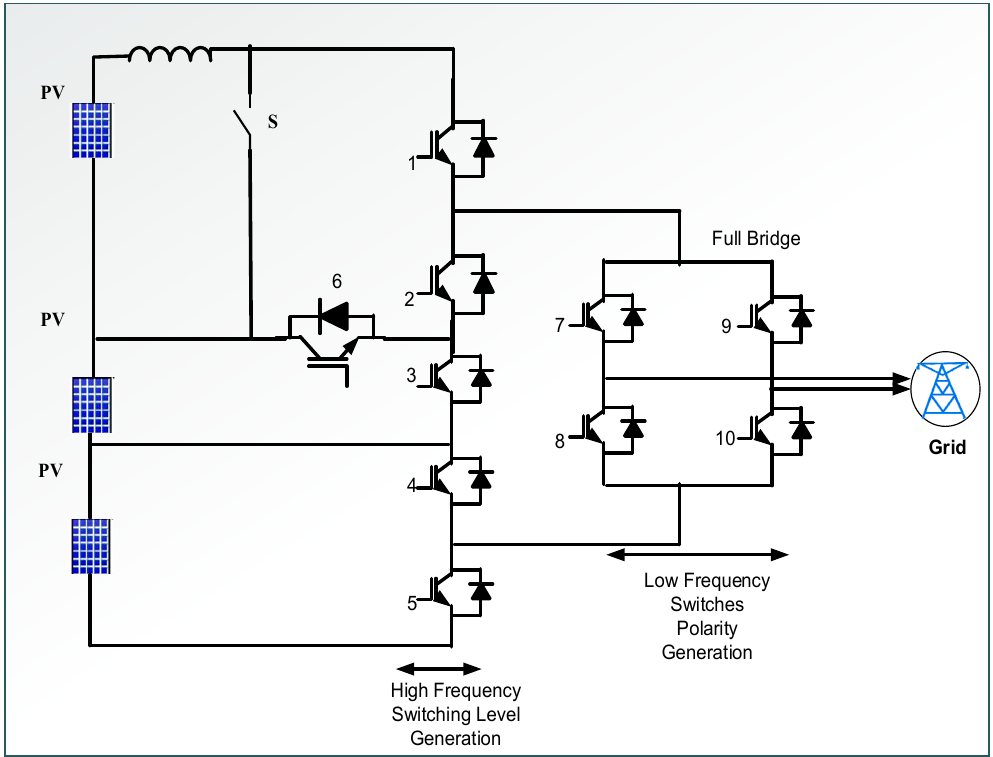
Figure 5. Single-phase multi-level inverter RV topology.